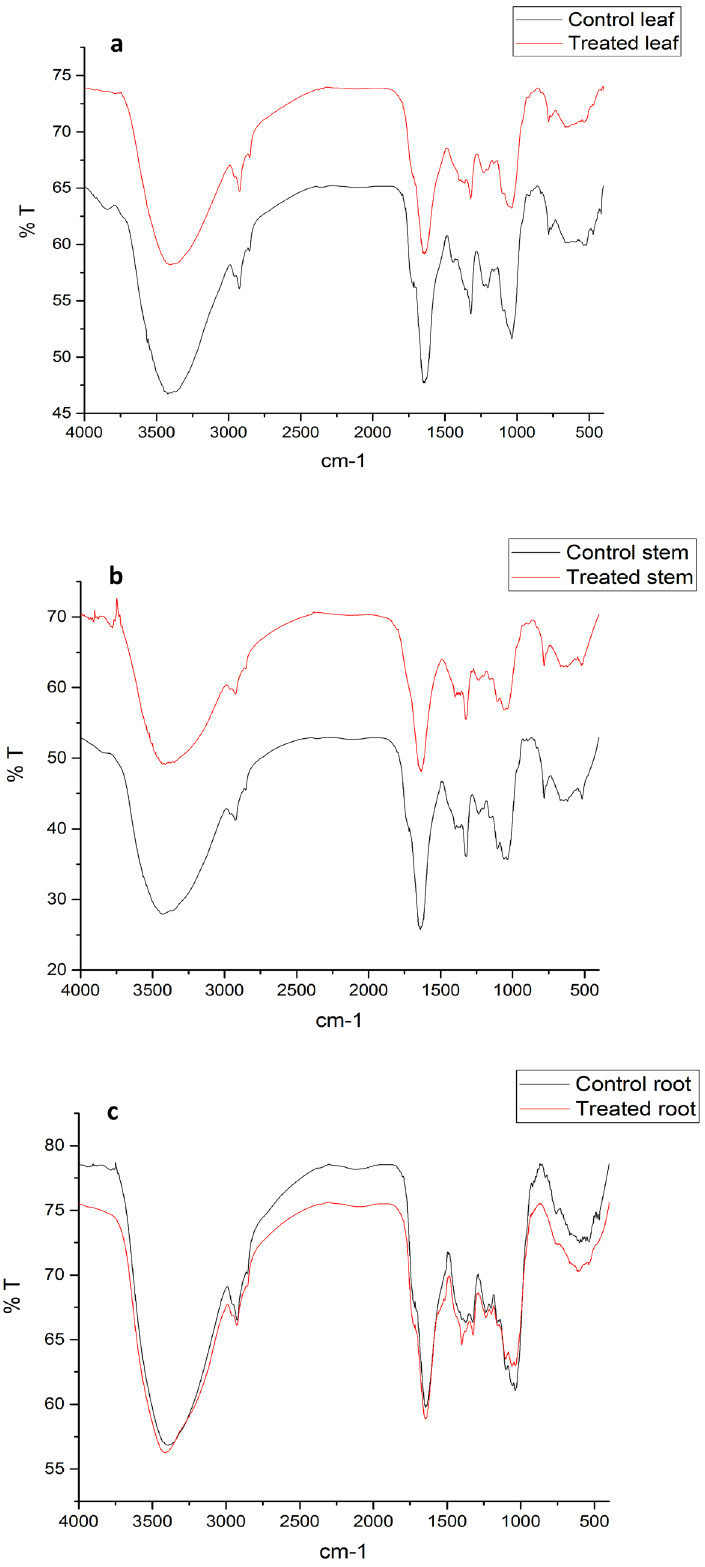
Figure 9. FTIR spectra of control and Sb treated biomass of T. natans : ( a ) control and Sb treated leaf, ( b ) control and Sb treated stem, ( c ) control and Sb treated